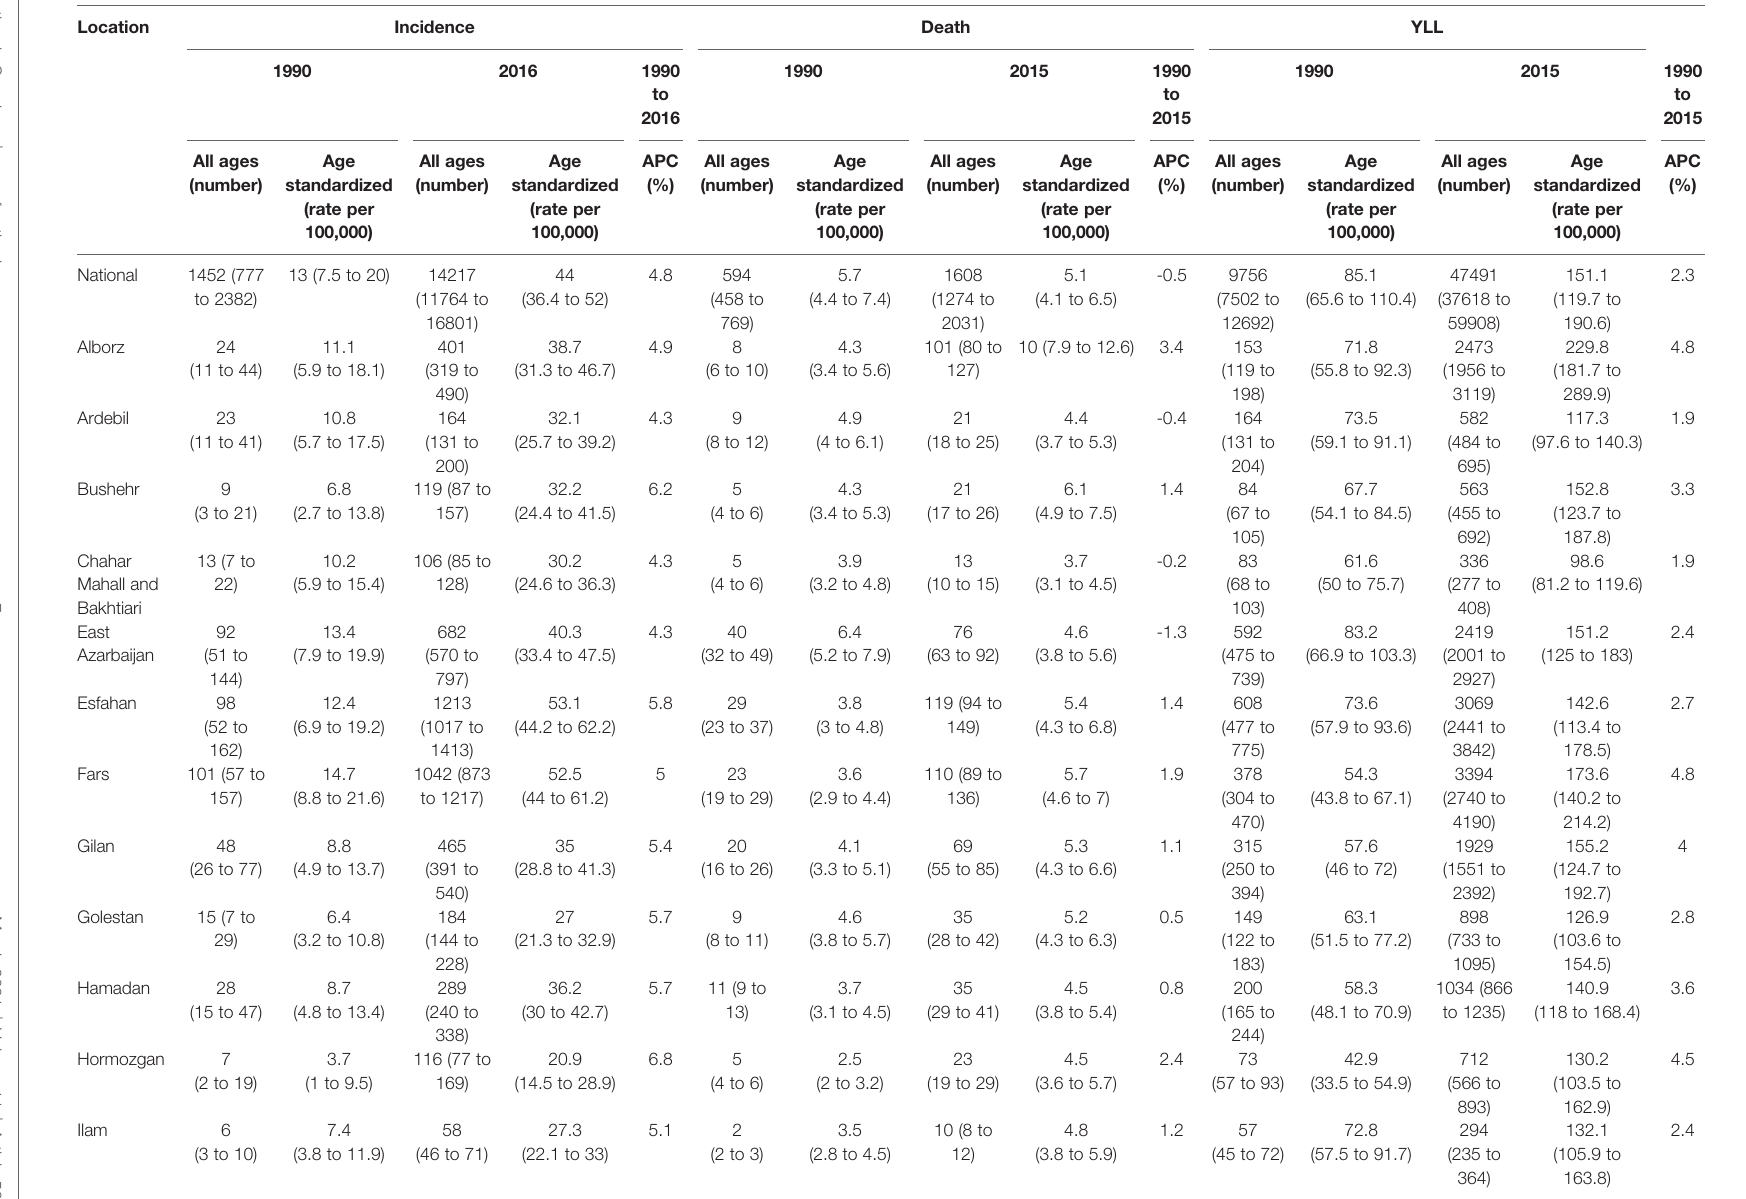
TABLE 1 | Number, rate and APC of Incidence, mortality and YLL at national and subnational levels.